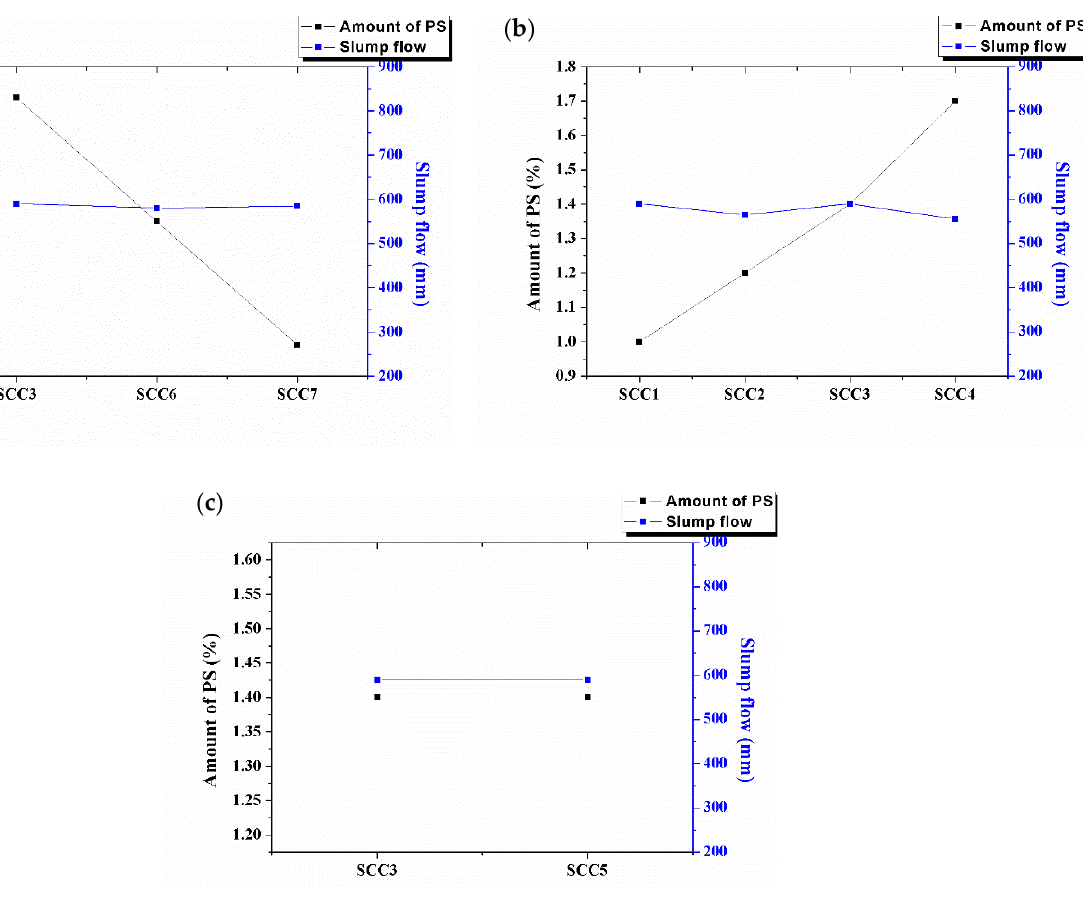
Figure 3. Different influence factors on amount of PS and slump flow of SCCs. ( a ) amount of GDS; ( b ) W/B; and ( c ) amount of sodium